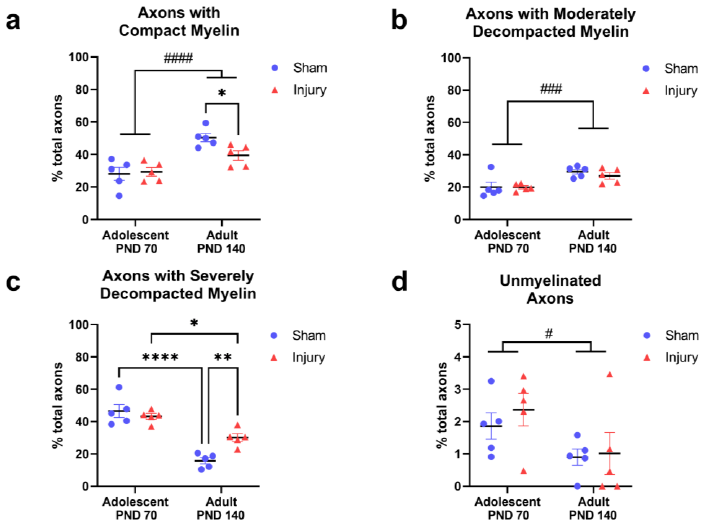
Figure 3. Percentage of axons classified based on myelin appearance in sham and injured rats at adolescence (PND 70) and adulthood (PND 140). Data were averaged per animal and presented as group ( n = 5) means ± SEM for the following axon classifications: axons with compact, electron-dense myelin ( a ); axons with moderate myelin decompaction ( b ); axons with severely decompacted myelin ( c ); unmyelinated axons ( d ). Statistical comparisons were made between groups. #### indicate main effect p < 0.0001; ### p < 0.001; # p < 0.05. **** indicate post hoc comparison p < 0.0001; ** p < 0.01; * p < 0.05. Additional significant effects were omitted from panel ( c ) for space and clarity, including a main effect of age ( p <